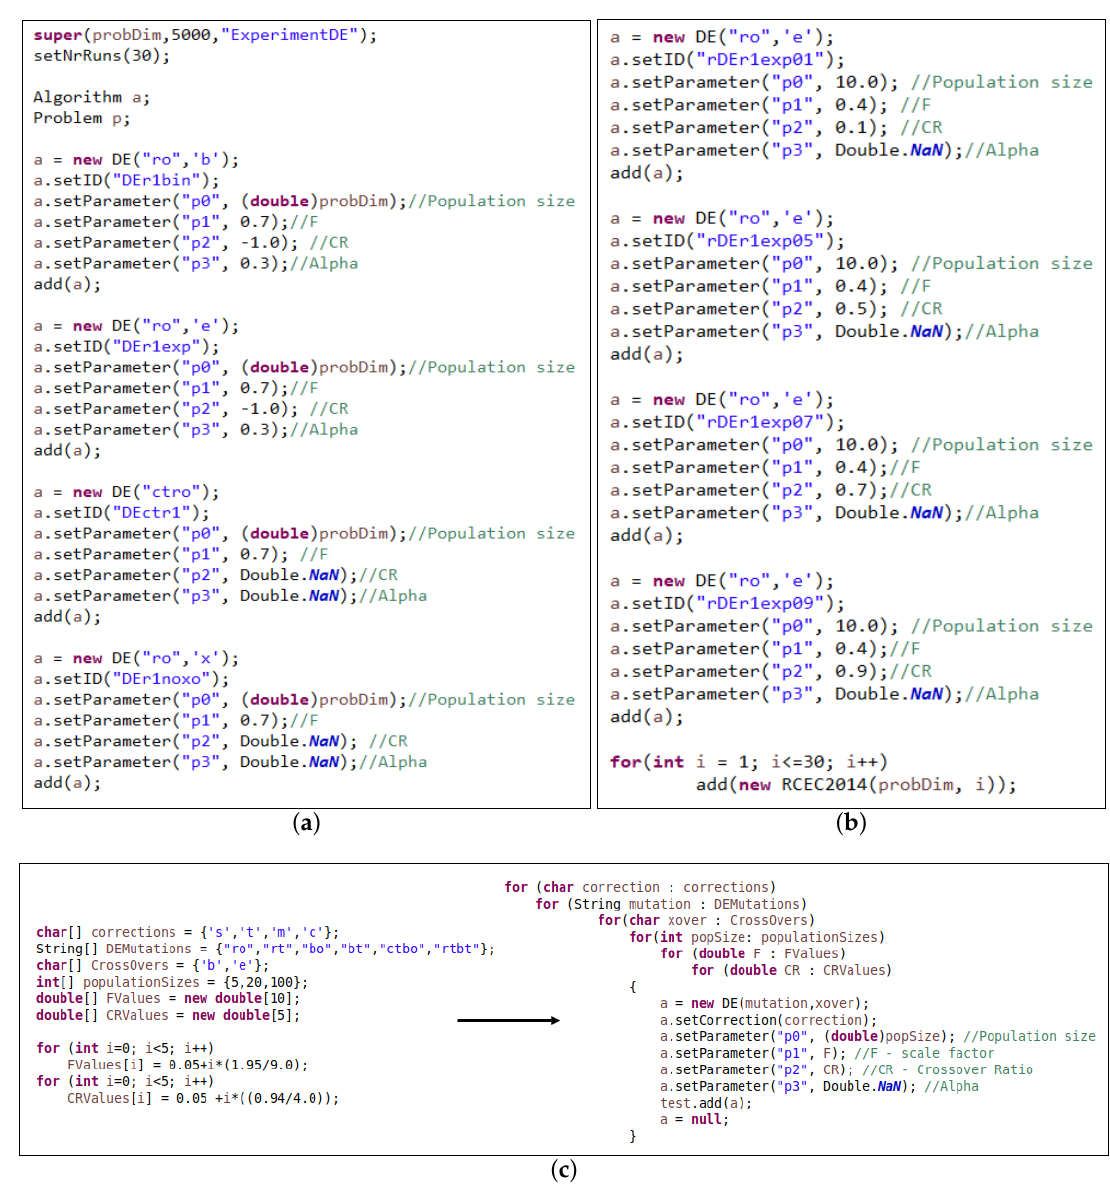
Figure 2. Examples from experiment classes (original files were downloadable from [17]) for parameter tuning and algorithmic behaviour testing, i.e., the same algorithms are included in the same experiment under different parameter configurations. The fragment of code reported in ( a ) refers to an experiment performed for the studies in [4,53] located in SOS → src → experiments → rotInvStudy → CEC11.java . The file RCEC14TuningDEroe.java , from which the segment of code in ( b ) was taken, can be found in the same folder. In this case, the DE/rand/1/exp algorithm executes with three different values for the crossover rate parameter C r over the 30 rotated versions of the problems of the R-CEC14 (R indicates rotation flag) benchmark suite proposed in this article in Section 3. Finally, the fragment of code in ( c ) shows how to define compactly an experiment running 12 DE variants (each with four correction strategies) with several different parameter configurations, over one problem only, to find the most appropriate triplet (cid:104) population size,scale factor ( F ), crossover ratio ( C r ) (cid:105) . The complete class file for this example is located in SOS → src → mains → ExampleTuning.java